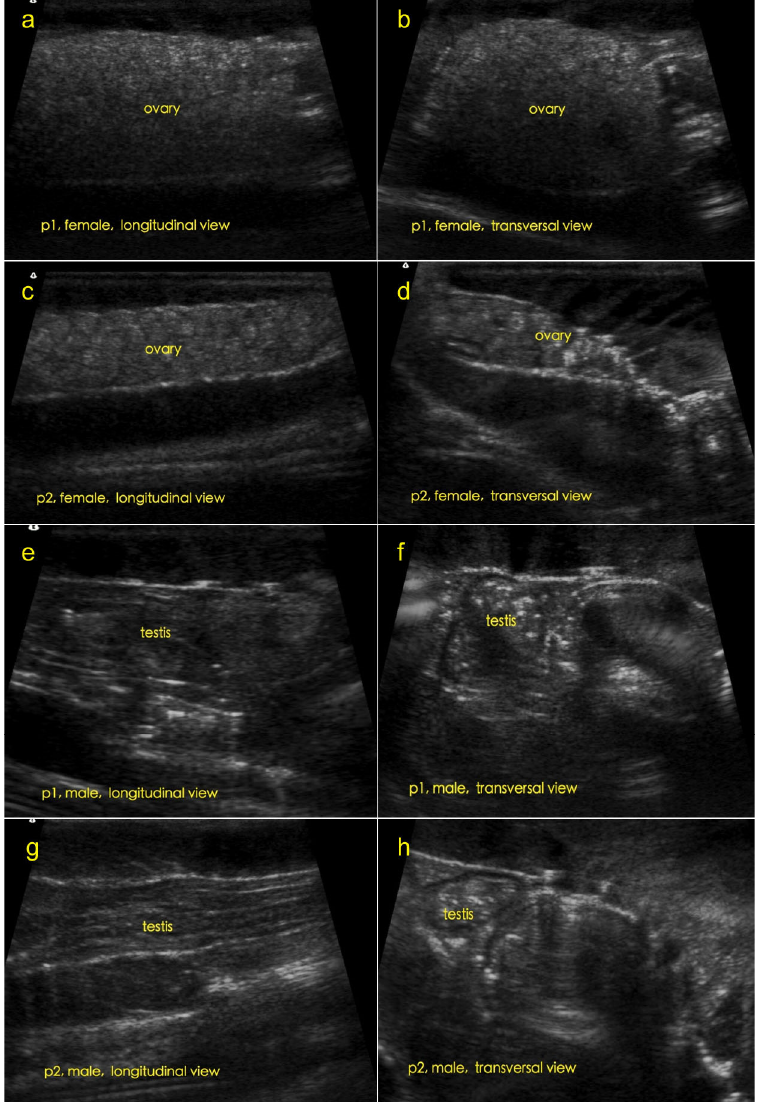
Figure 2. Ultrasound images of the gonads of mature Hucho bleekeri. Mature ovary ( a – d ) and testis ( e – h ) of p1 and p2 in both longitudinal and transversal views were shown.